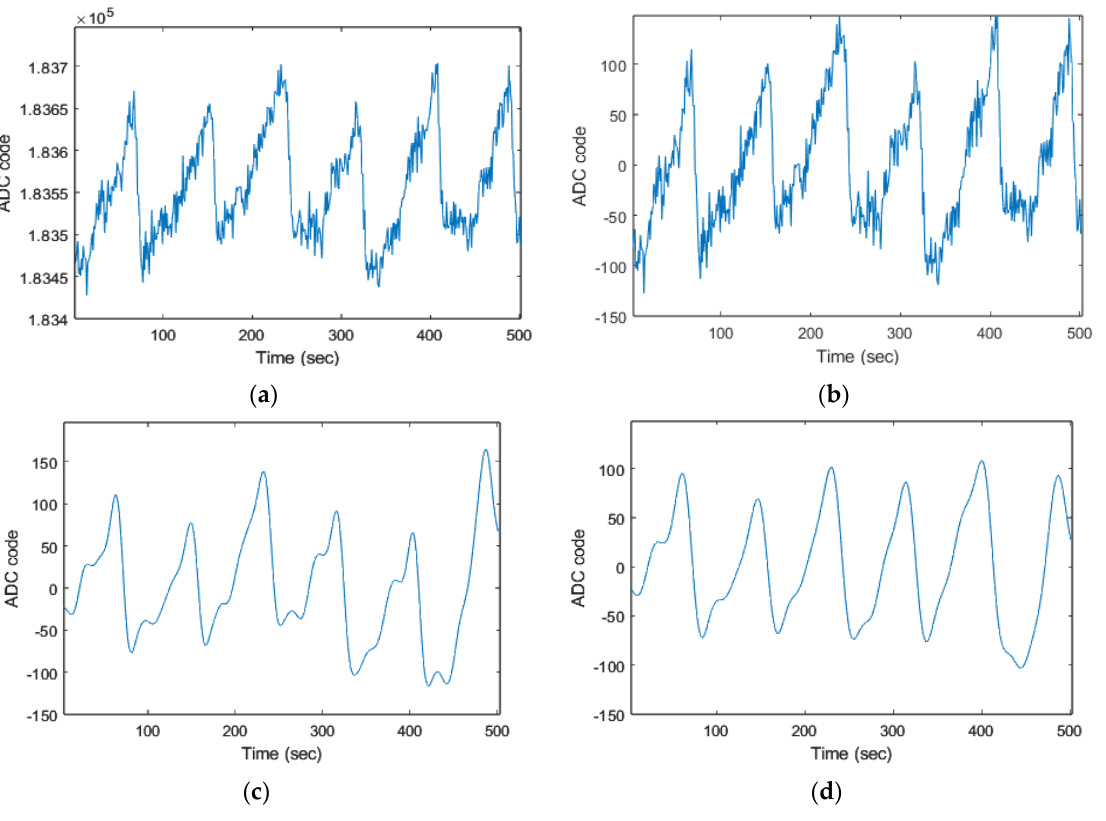
Figure 8. Preprocessing of the raw PPG signal: ( a ) original, ( b ) DC component removed, ( c ) Band-pass filtered, and ( d ) reduced motion artifacts.